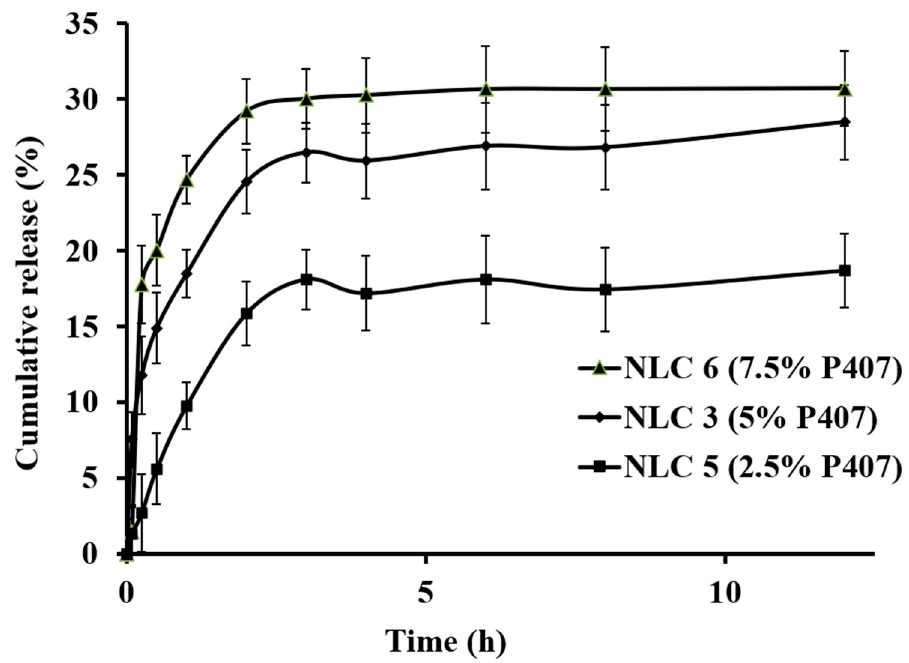
Figure 3. E ff ect of the P407 concentration on the percentage cumulative release of RLX from the NLCs.